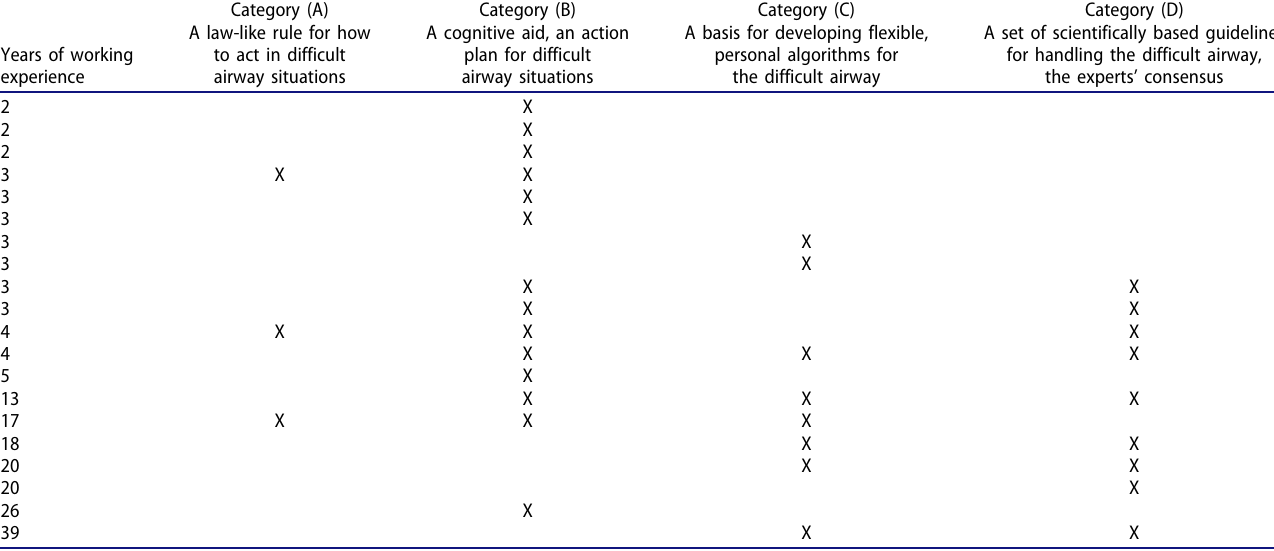
Table I. Ways of seeing algorithms for the difficult airway among 20 Swedish